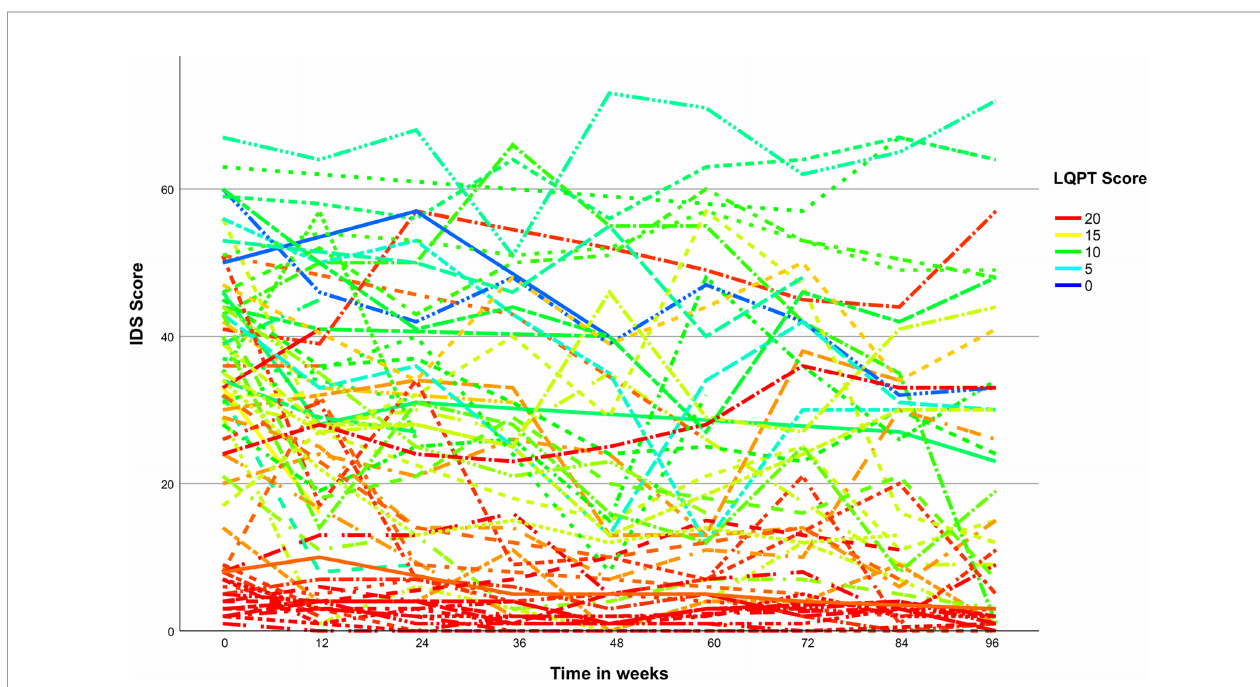
FIGURE 3 | Individual courses of depressive symptoms over time with color coding dependent on level of preoperational thinking. IDS, Inventory of Depressive Symptomatology; LQPT, Luebeck Questionnaire for Recording Preoperational